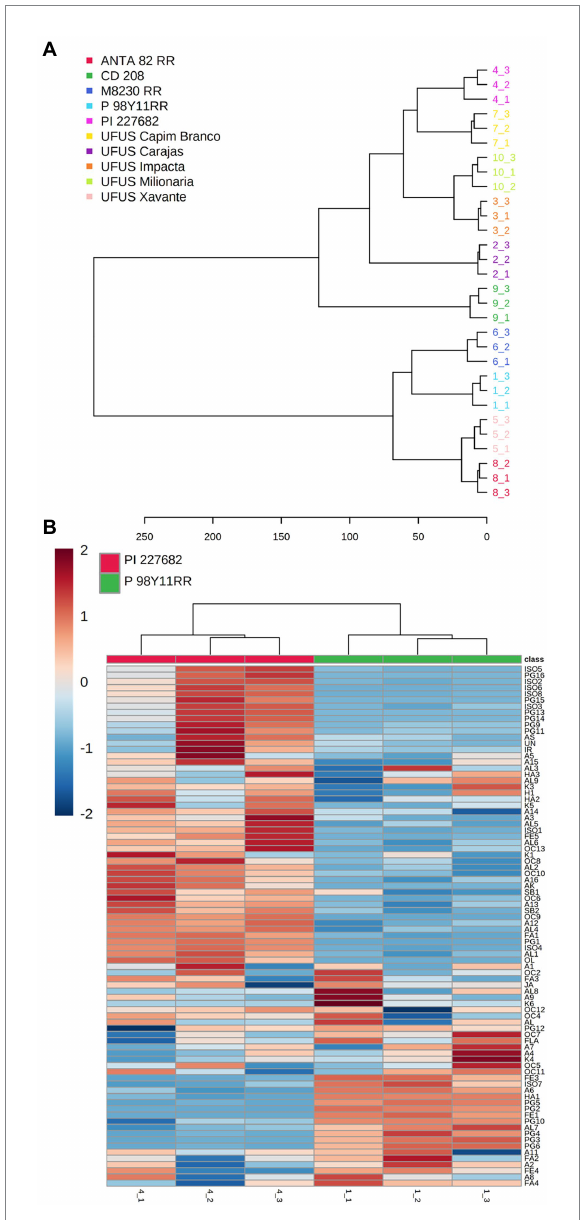
FIGURE 3 (A) Dendrogram showing the formation of groups according to similarity, indicating the similarity of the samples by distance, with groups formed from different Glycine max cultivars influenced by nonvolatile and volatile compounds. (B) Heatmap. Samples are represented in columns and metabolites represented by rows. The abundance of each metabolite is represented by a specific color. Upwards and downward regulated metabolites are indicated by different shades of red and blue,